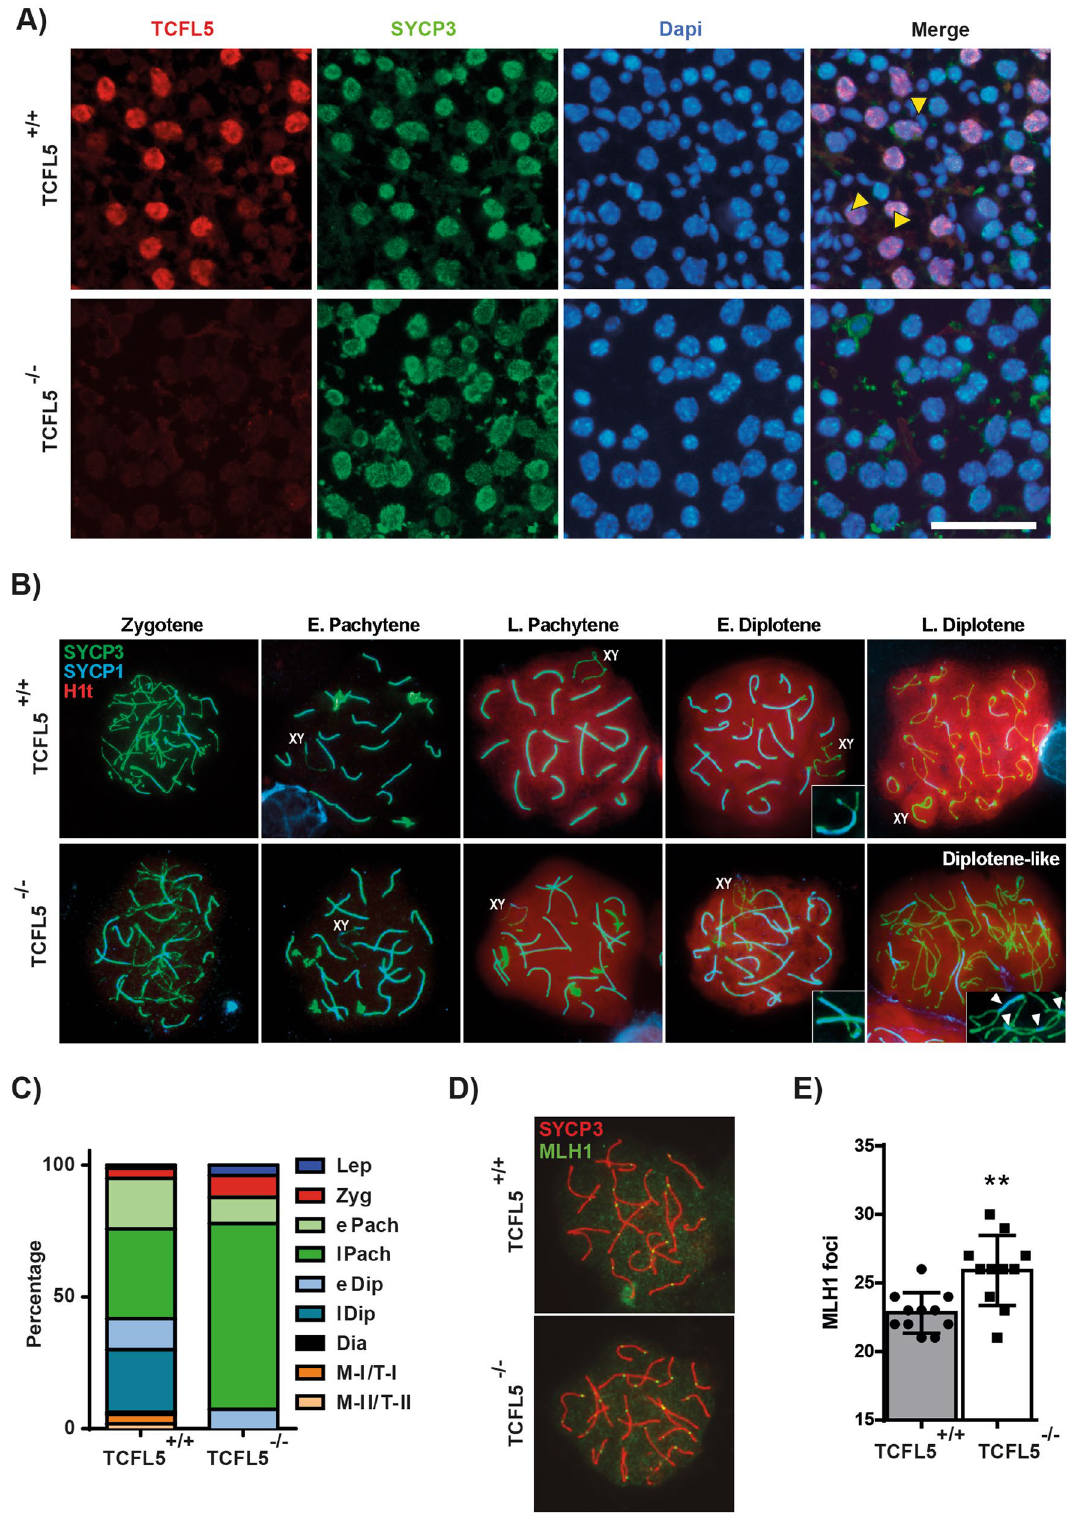
Figure 3. TCFL5 deficiency arrest cells in pachytene/diplotene transition. ( A ) Immunofluorescence of squashed seminiferous tubules in TCFL5 +/+ and TCFL5 −/− mice. TCFL5 (red), SYCP3 (green) and nucleus (Dapi, Blue) were detected. TCFL5 was only expressed in TCFL5 +/+ mice in cells that express SYCP3. Yellow triangles mark secondary spermatocytes and spermatids absence in TCFL5 −/− mice. Scale bar 40 µm. ( B ) Immunofluorescence of spread spermatocytes in TCFL5 +/+ and TCFL5 −/− mice. SYCP3 (green), SYCP1 (blue) and H1t (red) were detected. SYCP3 staining appears disrupted in TCFL5 −/− mice. Scale bar 20 µm. ( C ) Quantification of meiotic stages in TCFL5 +/+ (n = 3) and TCFL5 −/− mice (n = 3). ( D ) Immunofluorescence of spread spermatocytes in TCFL5 +/+ and TCFL5 −/− mice. SYCP3 (green) and MLH1 (red) were detected. TCFL5 −/− mice presented more MLH1 foci. Scale bar 20 µm. ( E ) MLH1 quantification in TCFL5 +/+ and TCFL5 −/− mice. (n = 8), **p <